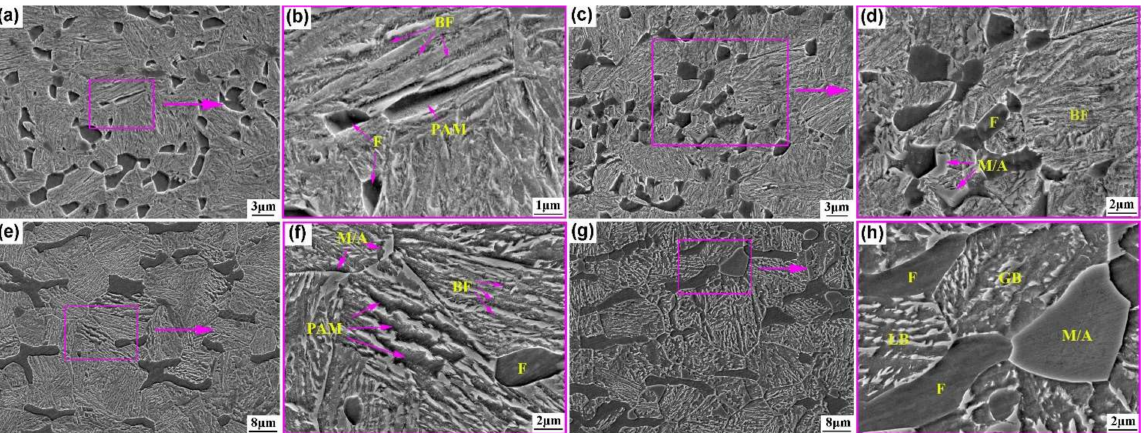
Figure 4. SEM images of the microstructures of the ( a – d ) 0.33C and ( e – h ) 0.21C steels austempered below Ms and above Ms after intercritical annealing. ( a , b ) 0.33C—280 ◦ C; ( c , d ) 0.33C—320 ◦ C; ( e , f ) 0.21C—340 ◦ C; ( g , h ) 0.21C—380 ◦